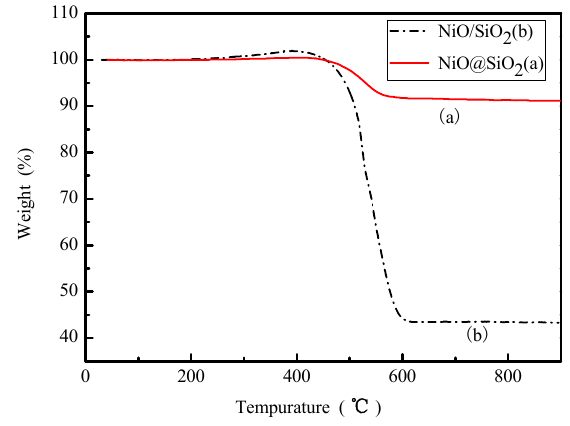
Figure 8. thermo ‐ gravimetric analysis (TGA) profiles of used catalysts after 100 h lifetime test for (a) NiO@SiO 2 and (b) NiO/SiO 2 .